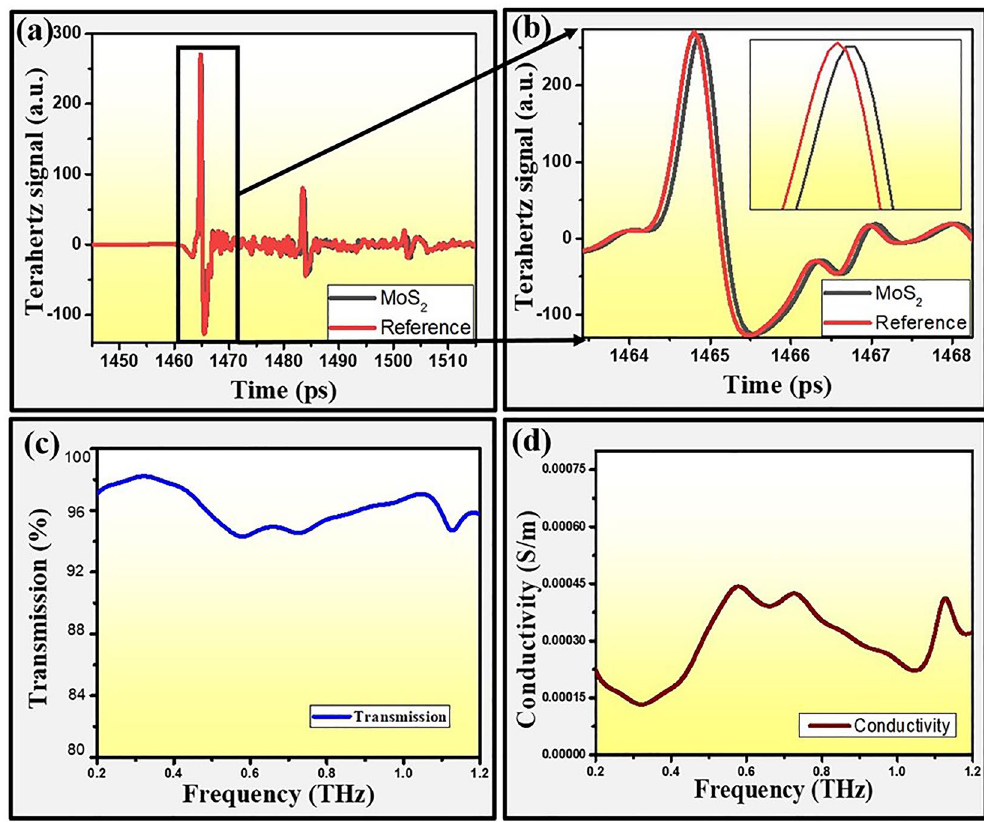
Figure 6. Time-domain terahertz spectroscopy. ( a ) THz signal transmitted through monolayer MoS 2 on sapphire substrate. ( b ) Magnified view of transmitted THz pulse. ( c ) Transmitted THz amplitude through monolayer MoS 2 grown on sapphire substrate. ( d ) Extracted sheet conductivity of monolayer MoS 2 on sapphire substrate in THz frequency